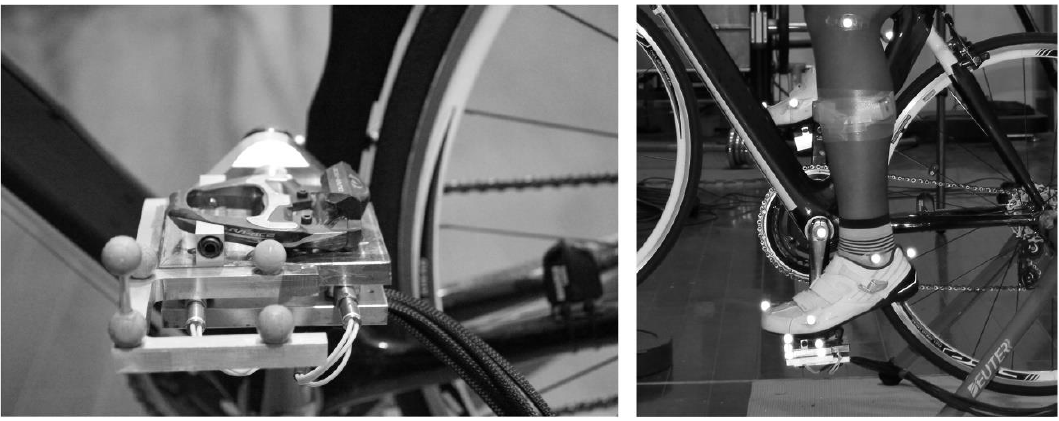
Figure 1. Image of the instrumented pedal force system with cleat fixed on the pedal.